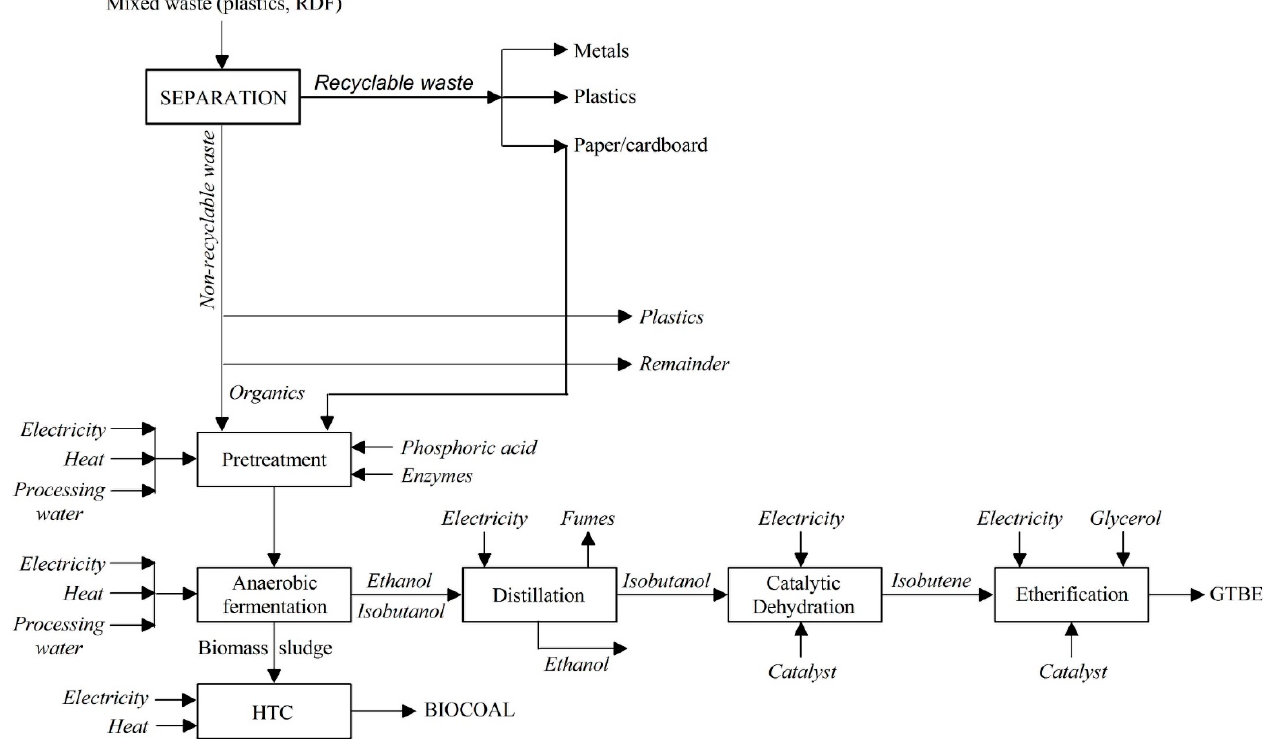
Figure 4. Flowchart of the integration of BioRen into the Renasci concept.